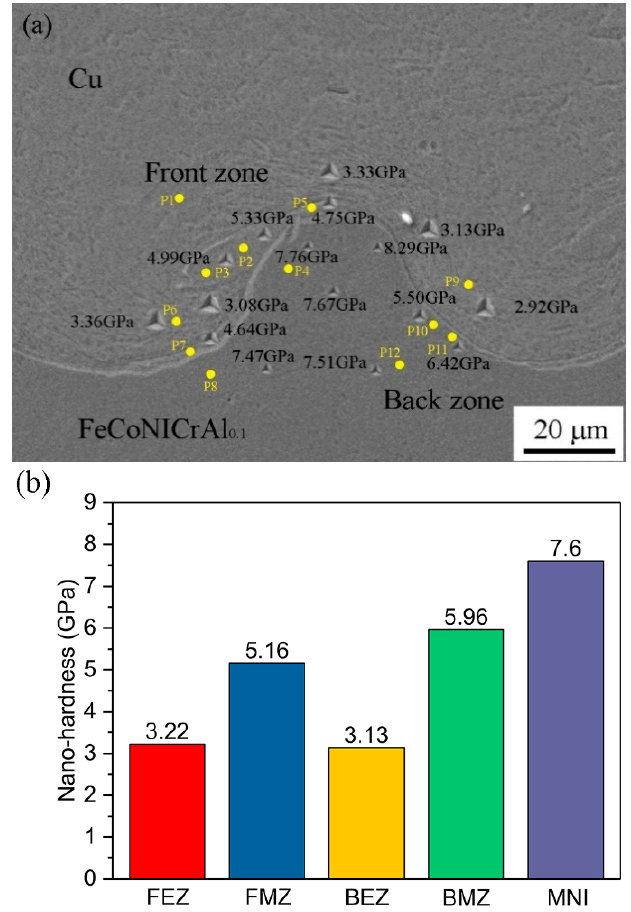
Figure 6. ( a ) Nanometer indentation test results of welded joints; ( b ) nanometer indentation data for selected areas.